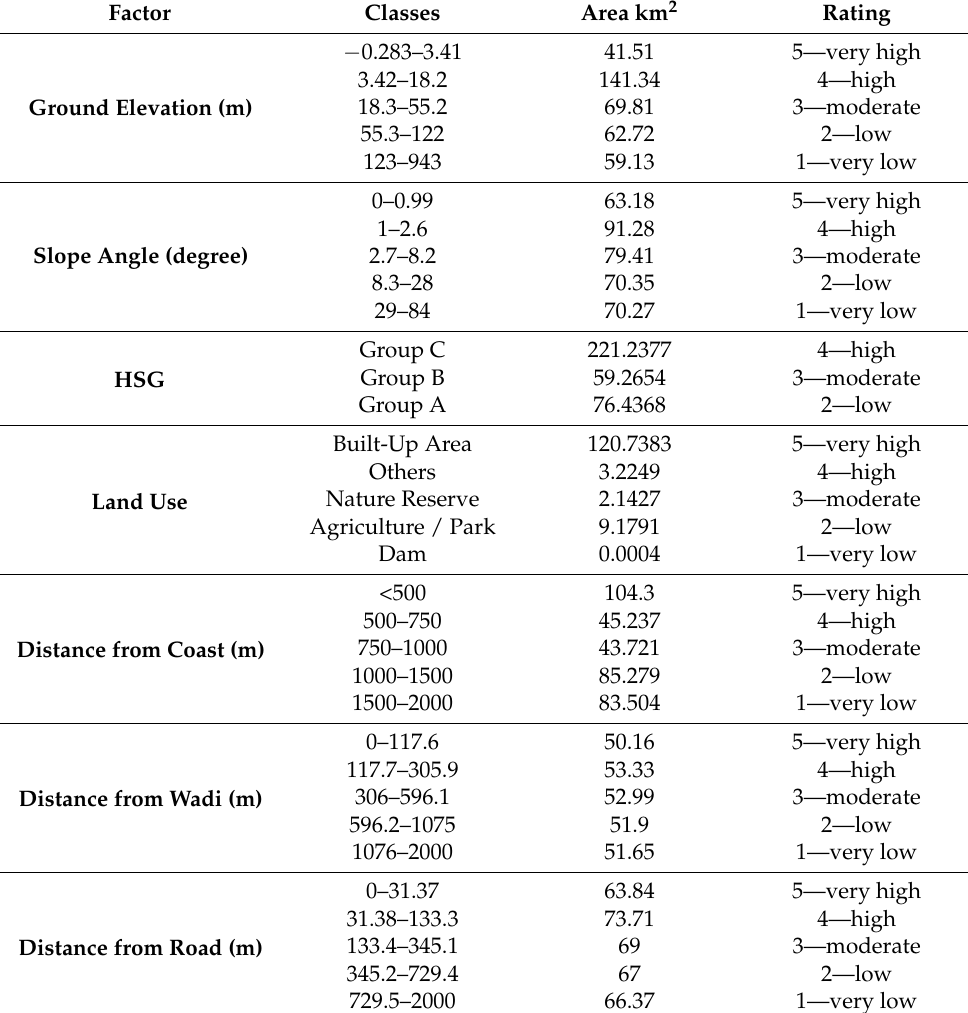
Table 1. The selected factors involved in mapping coastal flood susceptibility, their classes and their